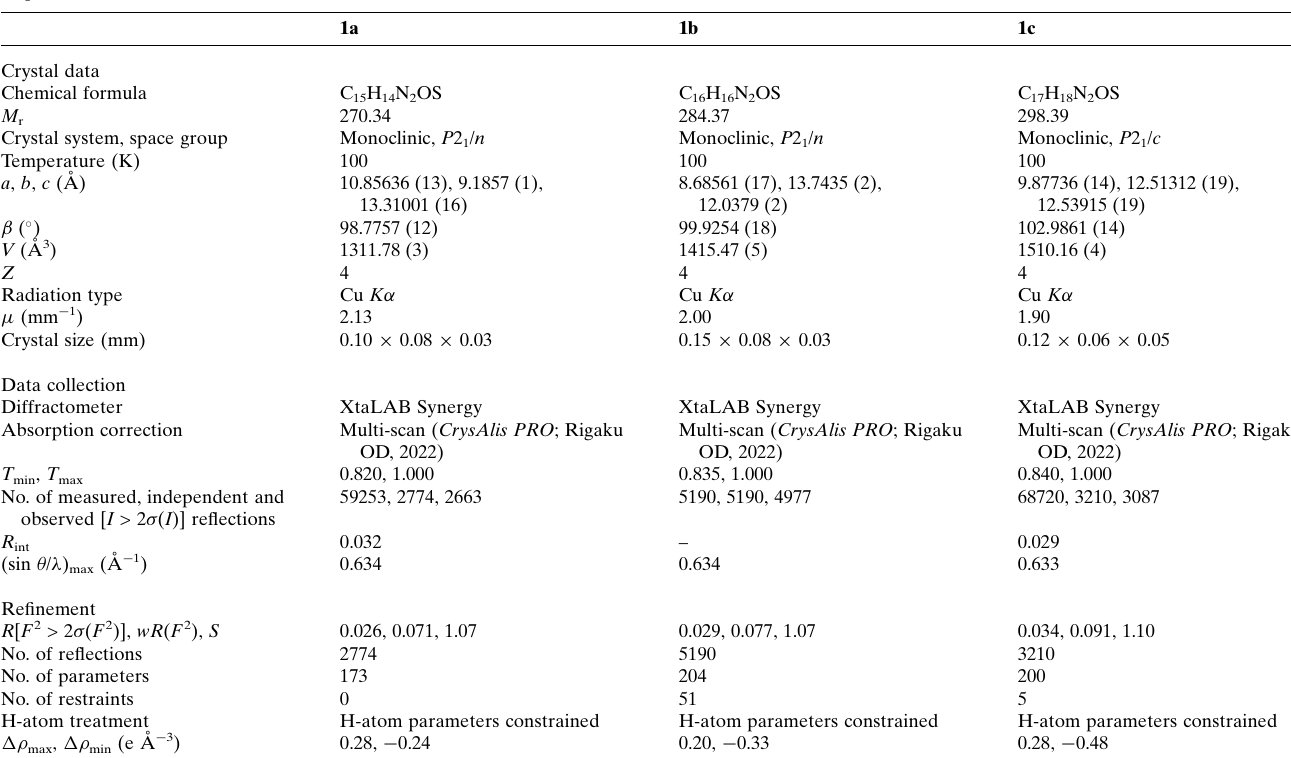
Table 7 Experimental details.